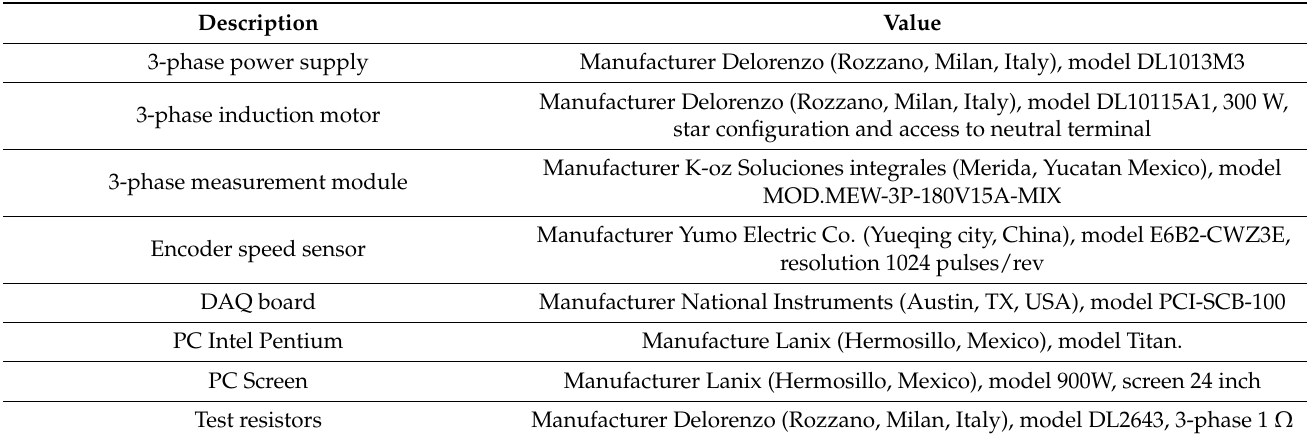
Table 2. Instrumental equipment specifications.